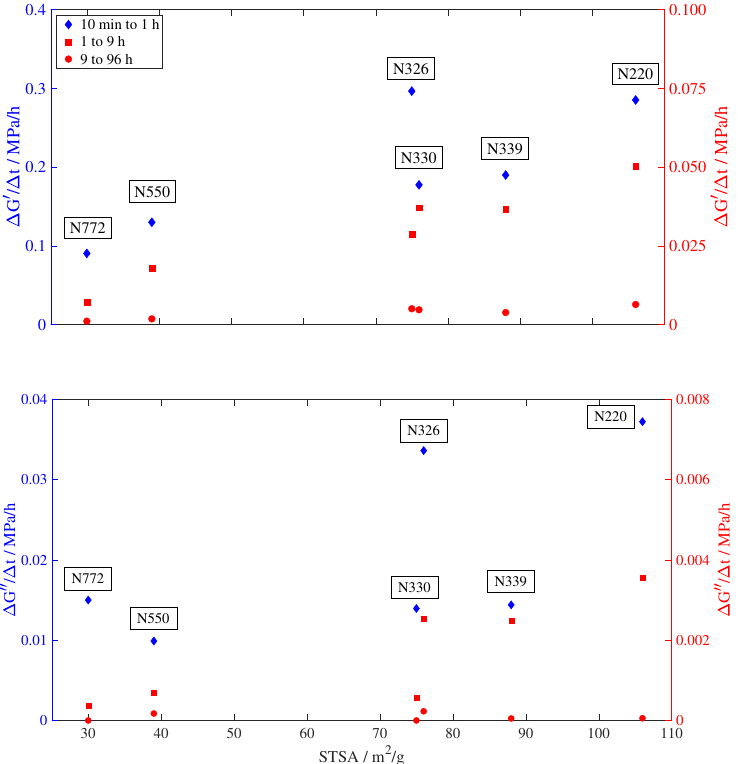
Figure 7. Dependency of the storage and loss modulus slope on the external surface area (STSA). Slopes are calculated from 10 min to 1 h (blue diamond), 1 to 9 h (red square), and 9 to 96 h (red circle).